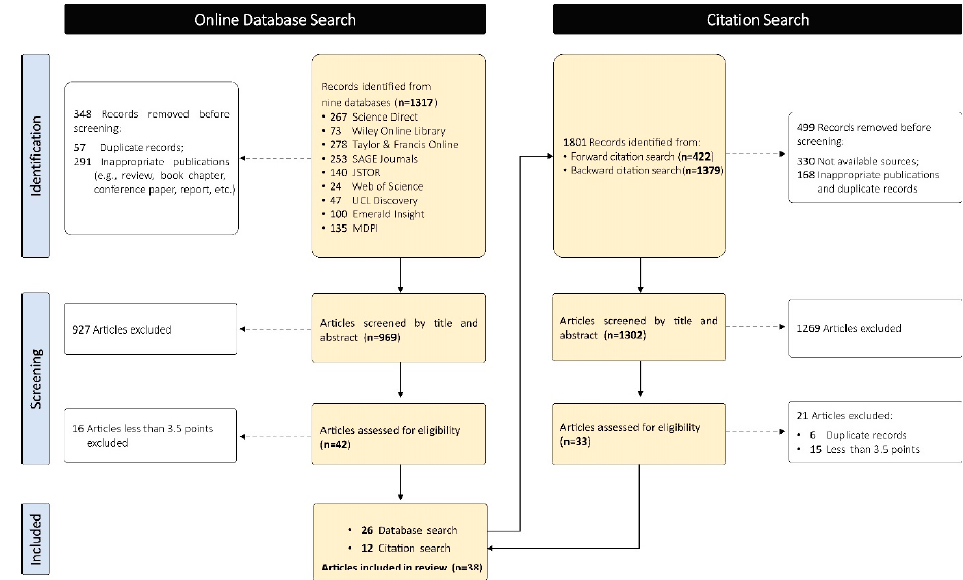
Figure 1. Two rounds of data-selection flows based on the PRISMA templates [10,16] .